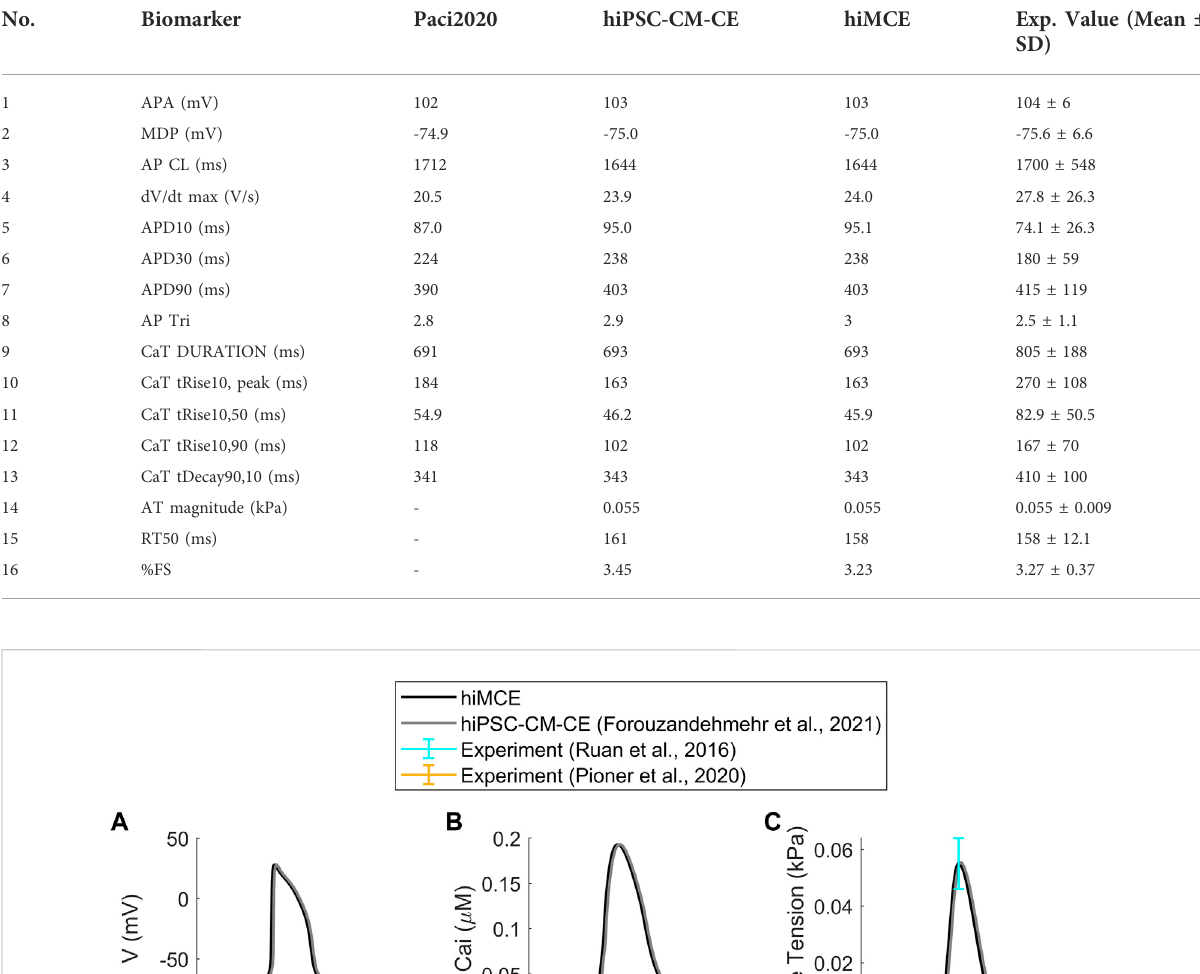
TABLE 6 Action potential (AP), Ca 2+ transients (CaT), and active tension (AT) calculated biomarkers in spontaneous condition and their comparison with Paci2020 and hiPSC-CM-CE model (i.e. no metabolite-sensitive CE) and the experimental values (Paci et al., 2018; Paci et al., 2020). APA: AP